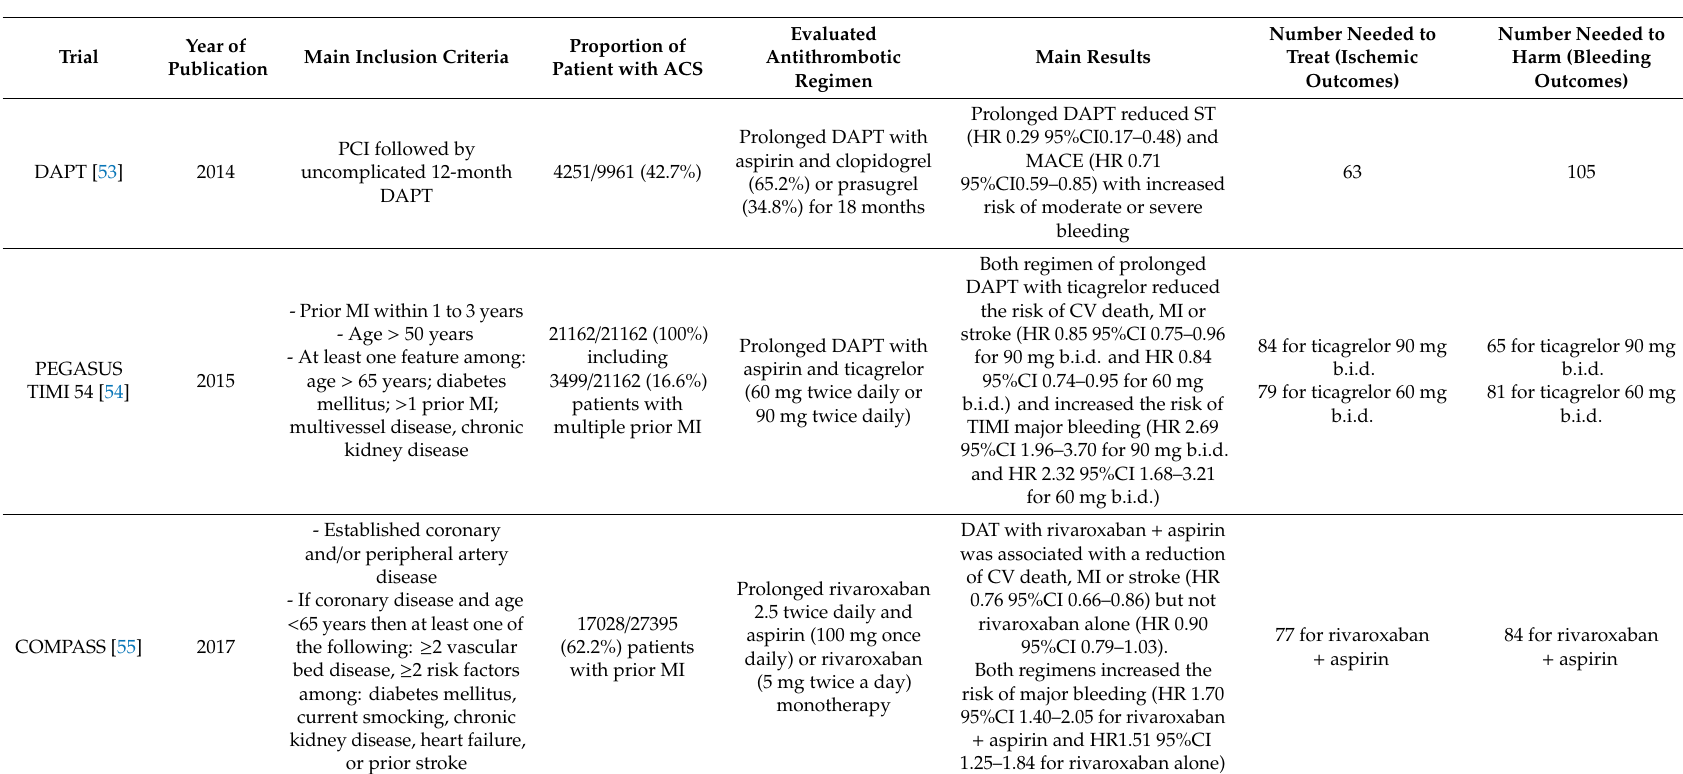
Table 1. Main trials evaluating prolonged antithrombotic regimen following